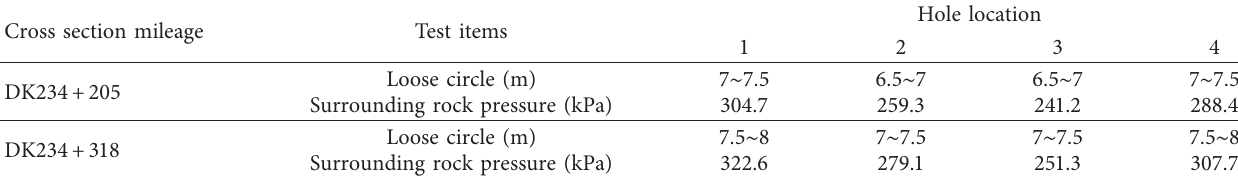
Table 7: Measured values of loose circles and surrounding rock pressures of typical section (m). Cross section